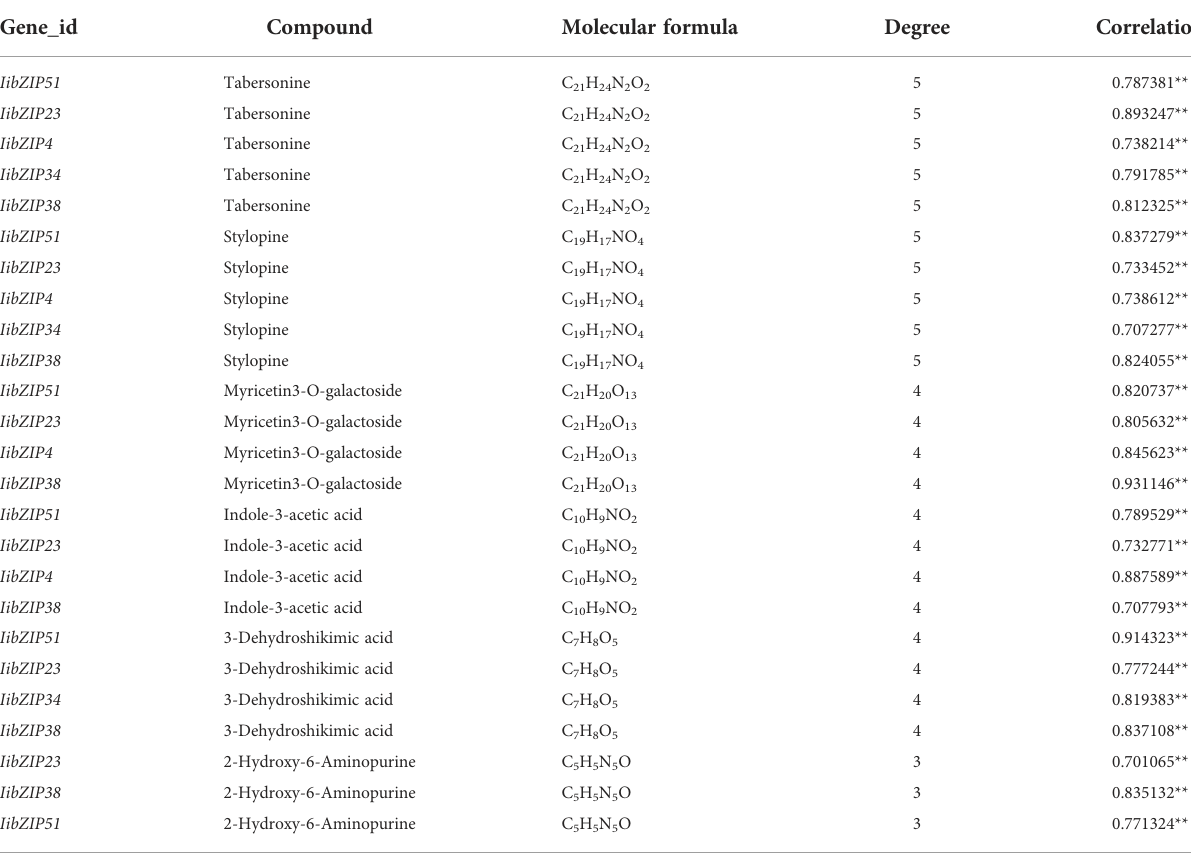
TABLE 1 Correlation analysis of differentially expressed IibZIP genes and differentially accumulated metabolites in leaves of I. indigotica under salt stress. Gene_id Compound Molecular formula Degree Correlation